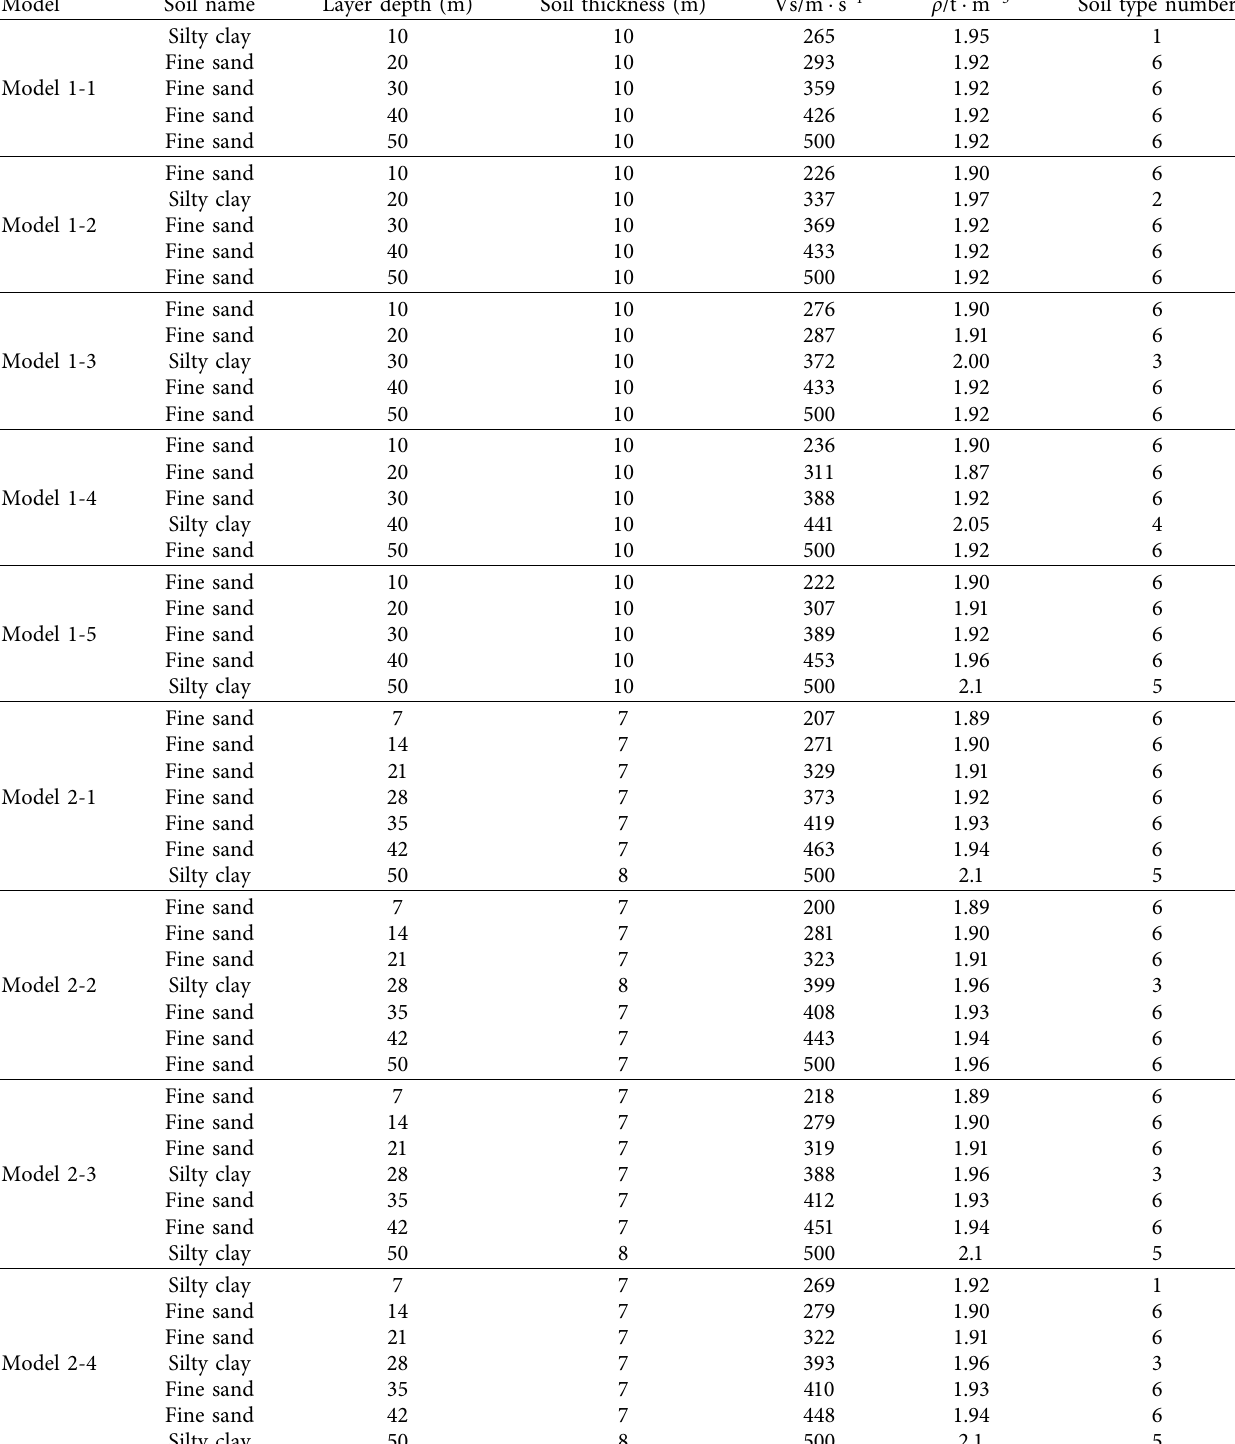
Table 1: Models and soil mechanical